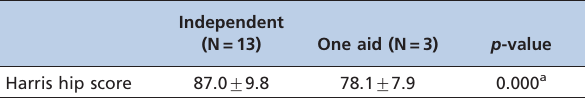
Table 4 - Preoperative mobility is predictive of the Harris hip